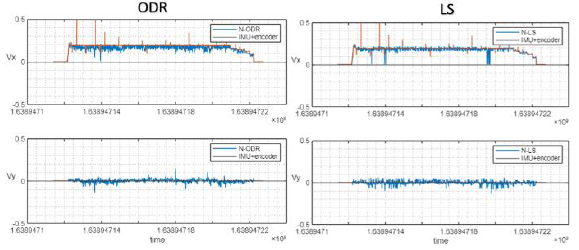
Figure 8. Comparison between Instantaneous velocity estimation using mmWave radar and IMU+encoder in scenario Table 2. Statistic comparison between Instantaneous velocity estimation using mmWave radar and IMU-encoder in scenario 1